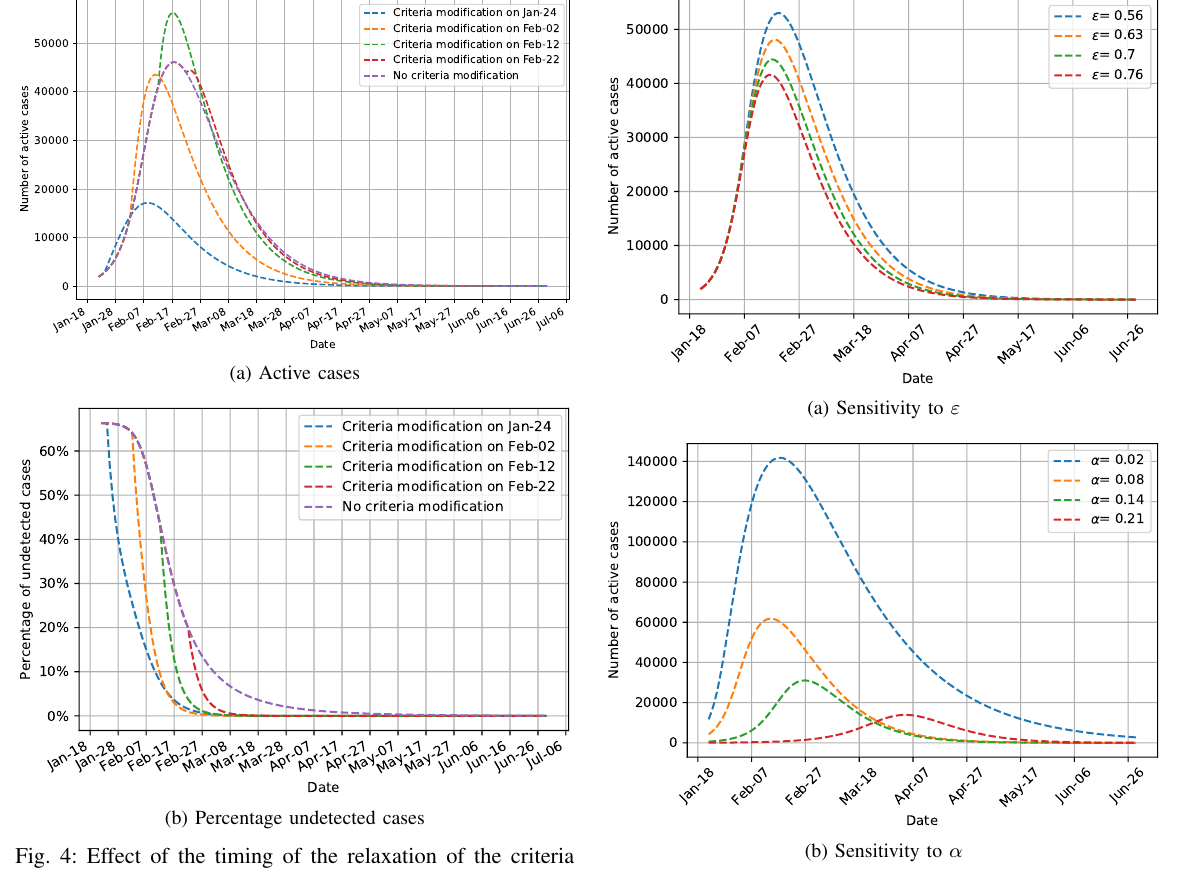
Fig. 5: Number of active cases when (a) the efficiency ε of protective measures and (b) detection rates α vary, with all other parameters as in Table IV. All dates in